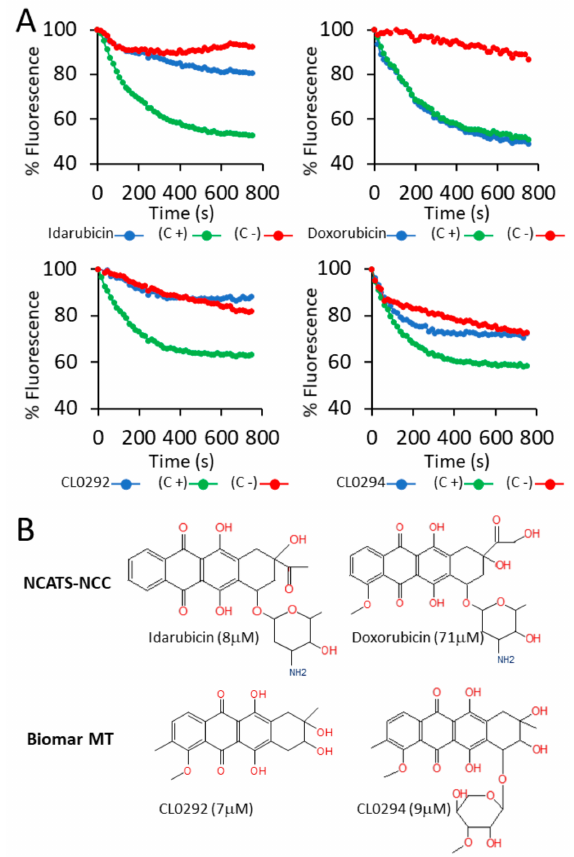
Figure 1. Anthraquinone inhibitors of SOS GEF activity. ( A ) Representative fluorescence tracings of GEF assays performed as described in M&M in the absence (green, positive control, C+) or the presence (blue) of the indicated 4 compounds (10 µ M) selected in the screening. As negative controls, the same reactions were carried out in the absence of externally added SOS (red, negative control, C − ). Horizontal time scale represented in seconds. Among almost 1000 compounds tested, only Idarubicin, CL0202, CL0294, and to a lesser extent Epirubicin (not shown), sharing a similar anthraquinone structure, showed inhibition in the three separate replicas performed for the screening. Doxorubicin, another molecule with a similar structure but inactive in GEFs assays at the concentration tested, is shown for comparison. ( B ) Chemical structures of the compounds assayed and selected in our screening of the NIH-NCATS library and the Biomar MT library that showed highest inhibitory activity in our in vitro SOS GEF assays. All compounds shared the same anthraquinone ring structure, differing only in the substitutions on the ring. Doxorubicin, which was basically inactive on SOS exchange reaction at the concentration used in the screening (see Figure 1A), has been used as a control throughout this